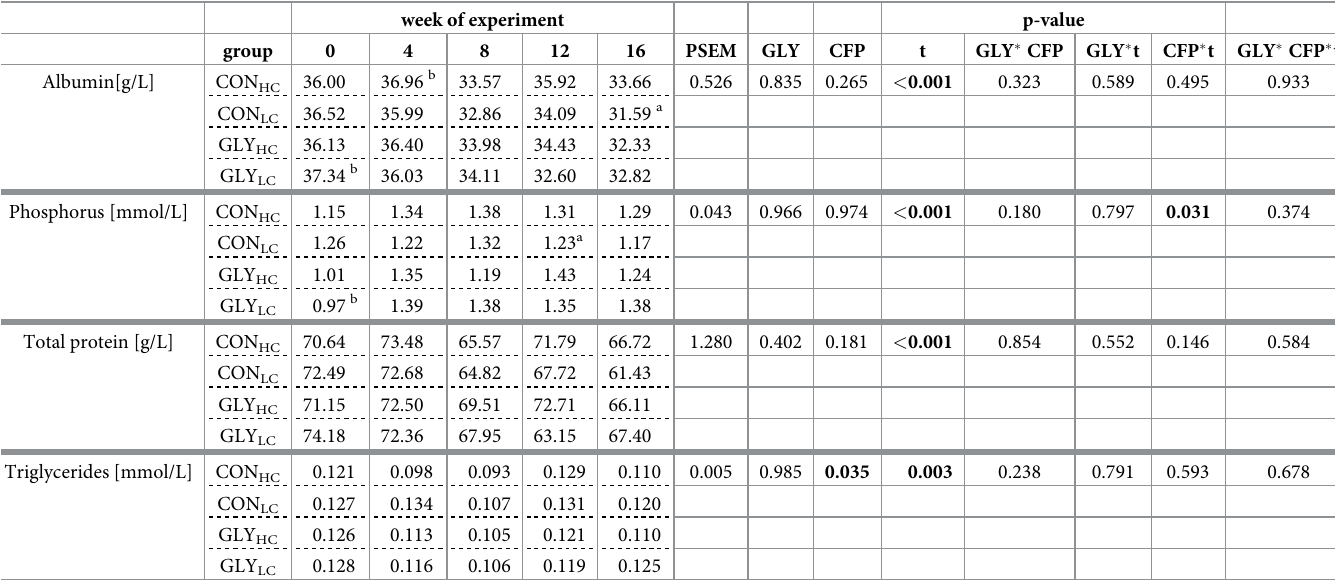
Table 1. Effects of GLY-contaminations and different CFP on blood metabolites.